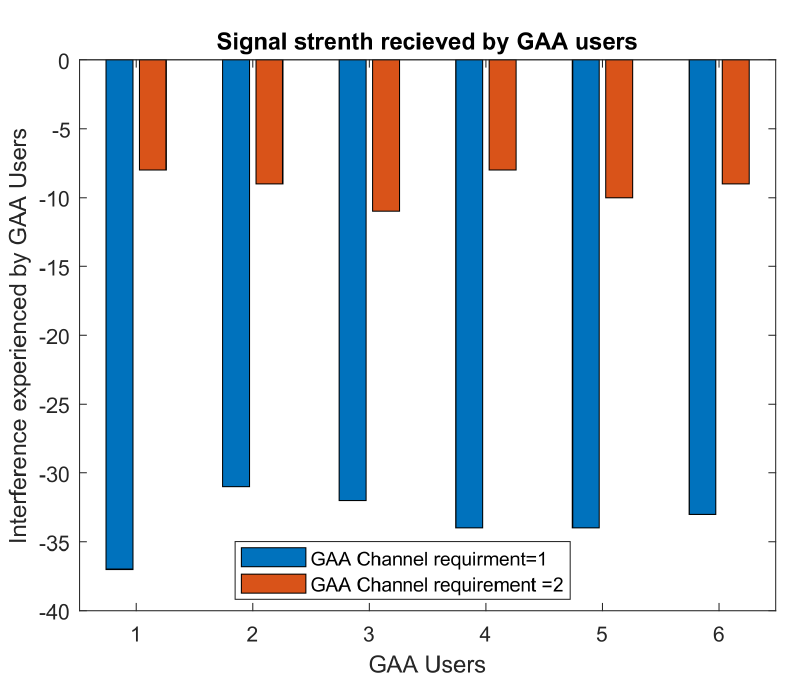
Figure 4. Signal strength received by GAA